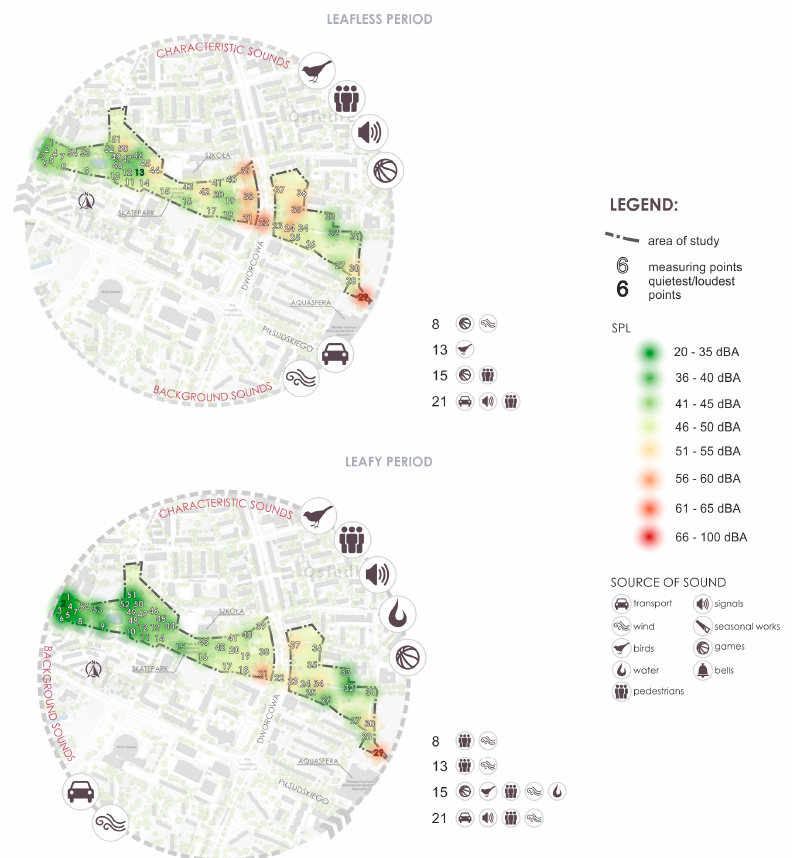
Figure 9. Results of evaluation of the soundscape (SPL measurements and characteristic sounds) presented in the map of the Kusoci´nskiego Park in the leafless and leafy period. The loudest area is located near Dworcowa Street and the Aquasfera Water Recreation and Sports Center. The characteristic sounds are described by pictograms in points 8, 13, 15, and 21.